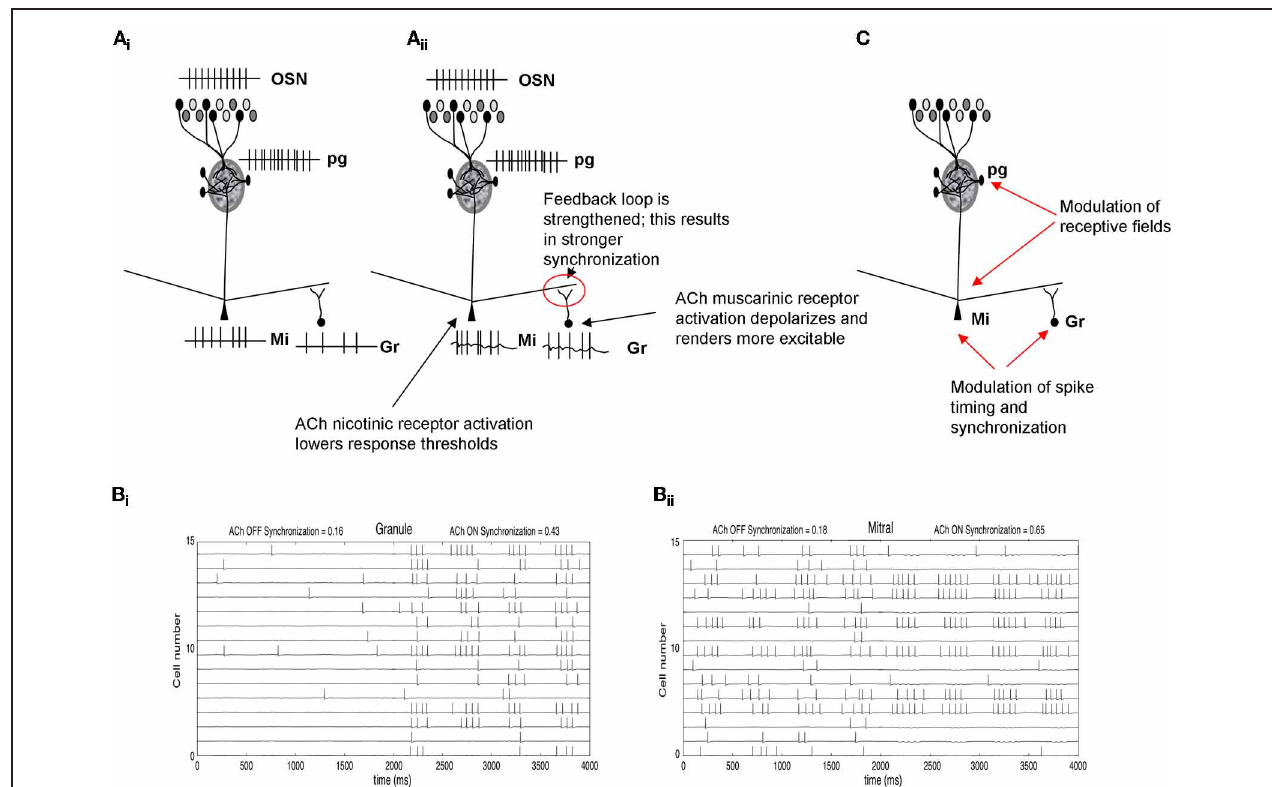
FIGURE 3 | Schematic depiction of cholinergic modulation of deeper layer synchronization and dynamics. (A i ) OSN activation by odorants is processed in the glomerular layer ( Figure 2 ) and creates an odor-specific response in mitral cells. In the example shown here, mitral cells respond with a spike train and in turn activate granule cells though excitatory synapses. (A ii ) Nicotinic ACh modulation depolarizes mitral cells and, at the same time, muscarinic receptor activation renders granule cells more responsive to input